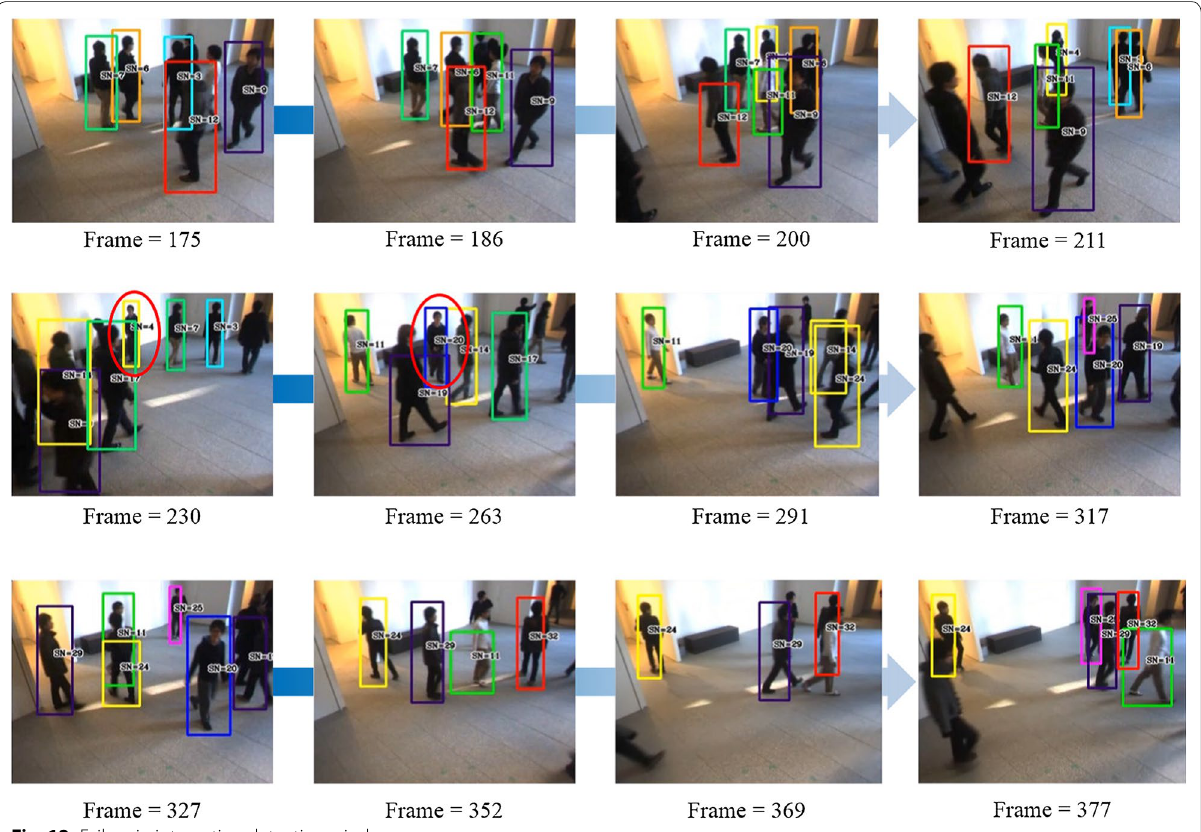
Fig. 12 Failure in integrating detection